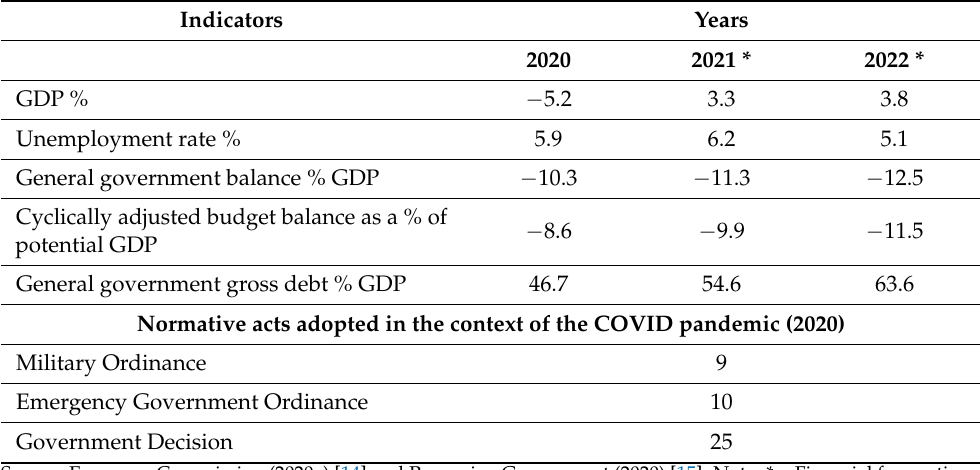
Table 1. The impact of the COVID-19 crisis on the Romanian